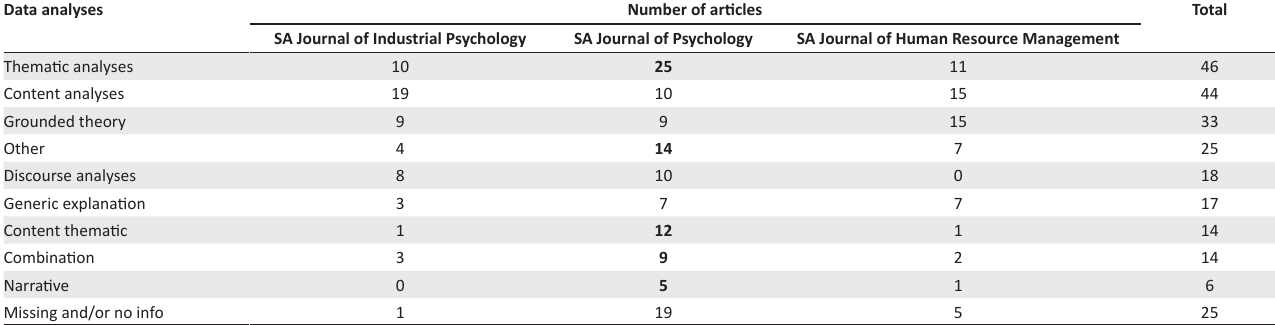
TABLE 4: Comparison of data-analysing techniques according to the respective journals. Data analyses Number of